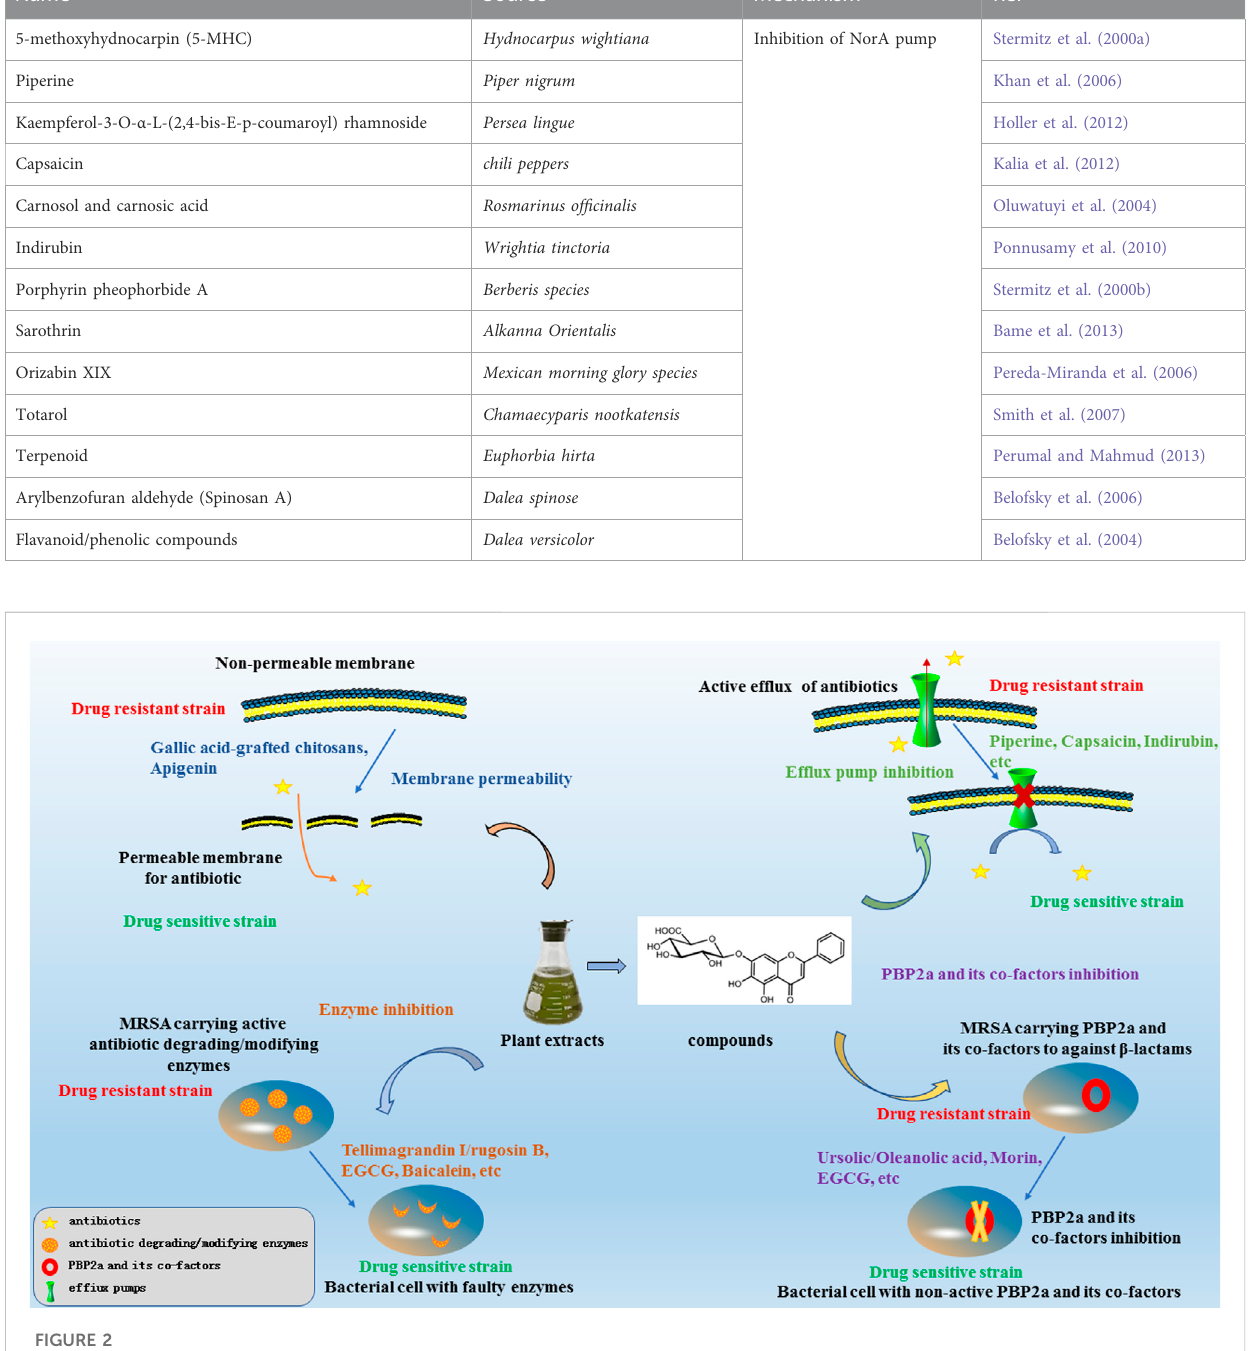
FIGURE 2 The mechanisms of antibacterial sensitizers against